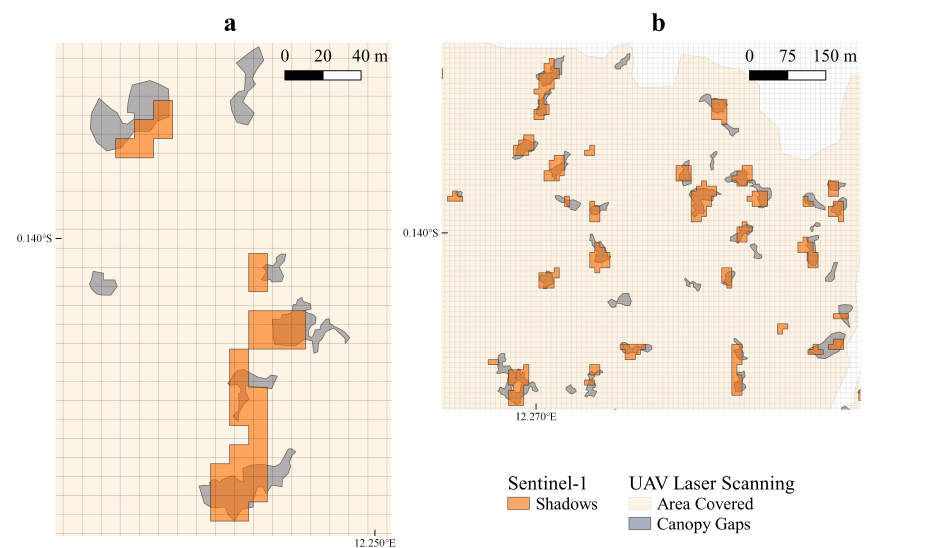
Figure 3. Sentinel-1 shadows overlaid in orange (using 25 post-logging images and no multilooking) against UAV LiDAR measured canopy gaps (grey) for two subsets of the study area. Example ( a ) shows offsets between shadows and canopy gaps in different directions, and a single shadow covering two canopy gaps. In ( b ), there are examples where a single canopy gap is covered by multiple shadows.